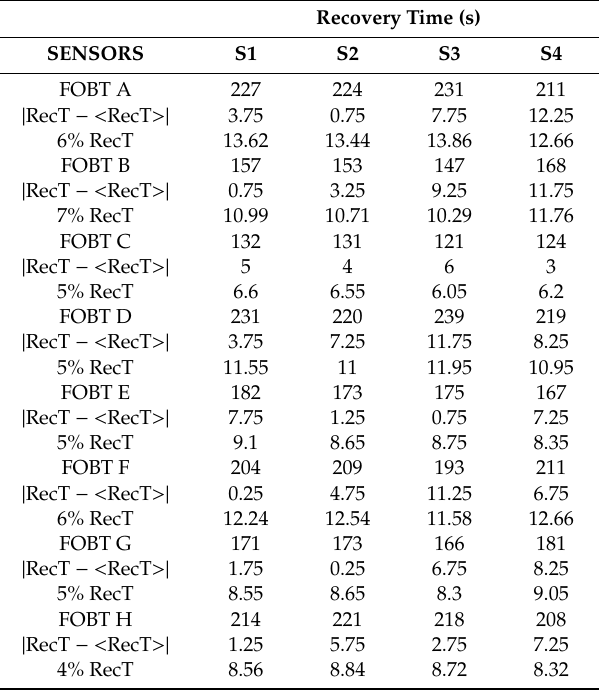
Table 7. Recovery times (RecT) to eight FOBT-positive fecal samples; absolute distance from mean value ( | RecT − < RecT >| ); and percentage of RecT below which the value of ( | RecT − < RecT >| ) stands for all